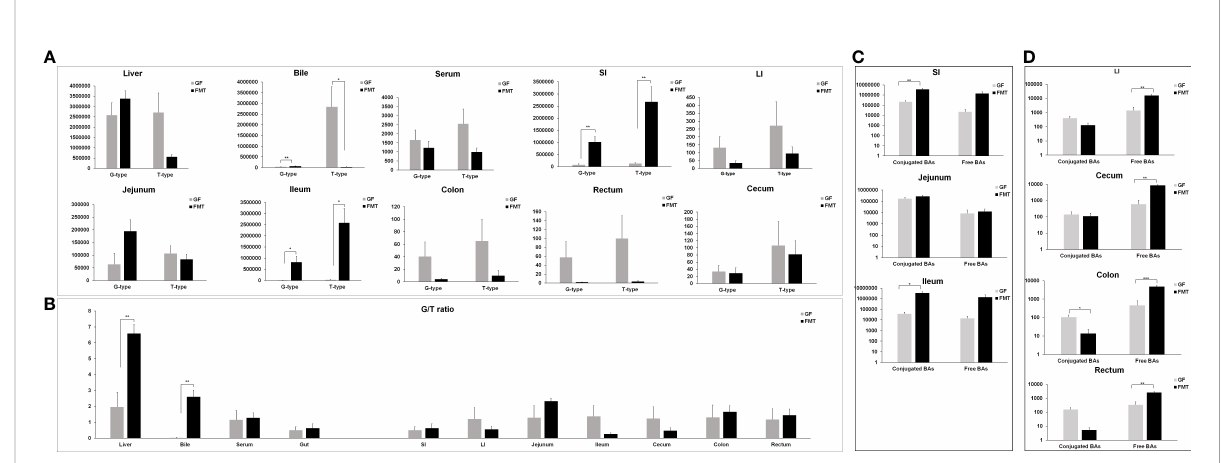
FIGURE 6 Glycine- and taurine-conjugated bile acids in FMT and GF piglets. (A) Glycine-conjugated (G-type) and taurine-conjugated (T-type) BAs in the liver, serum, bile, and intestine of FMT piglets compared to the GF group. (B) The glycine/taurine (G/T) ratio in the liver, serum, bile, and intestine of FMT and GF piglets. (C) Group differences of conjugated and free BAs in the small intestine. (D) Group differences of conjugated and free BAs in the large intestine. SI = small intestine including jejunum and ileum; LI = large intestine including cecum, colon, and rectum; Gut represents SI and LI; n = 5 – 6 samples/group. * P < 0.05, ** P < 0.01 indicate differences versus GF by the Welch Two-Sample t -test.